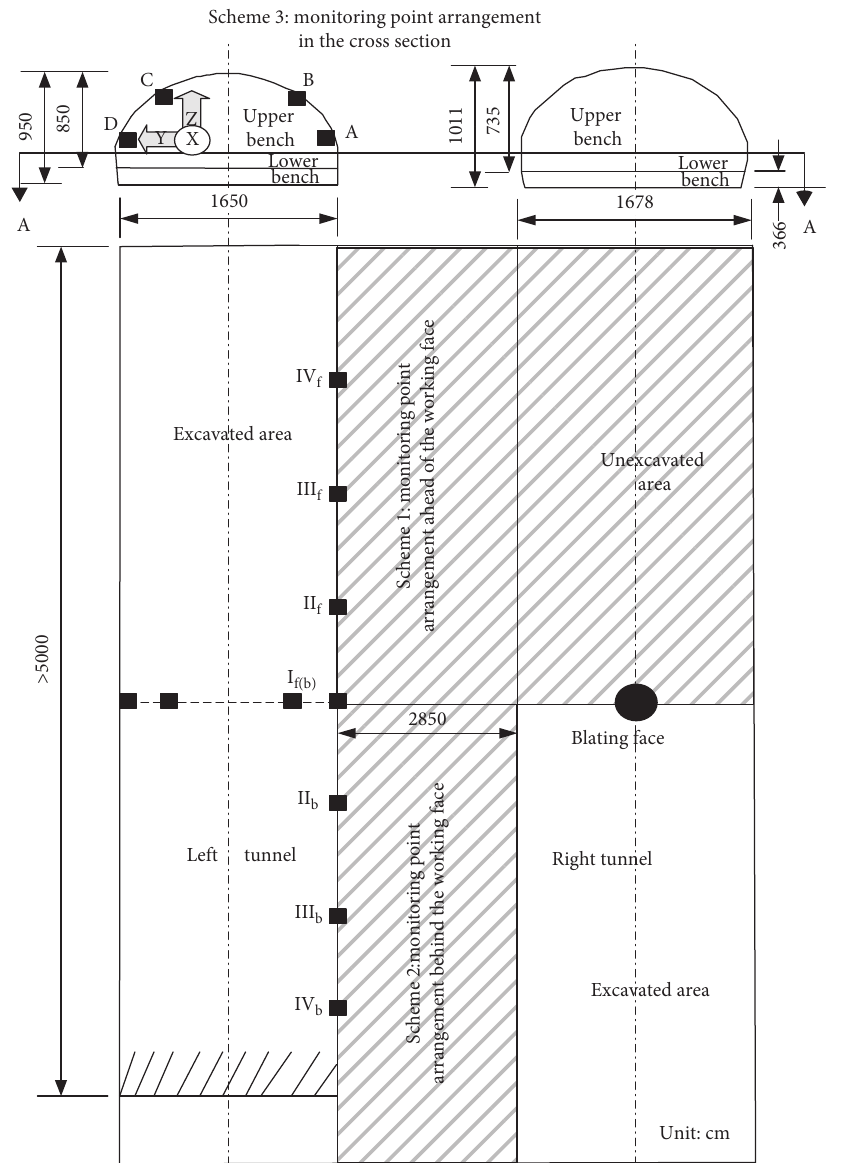
Figure 2: Relationship between the two tunnels and the layout scheme of monitoring points (unit: